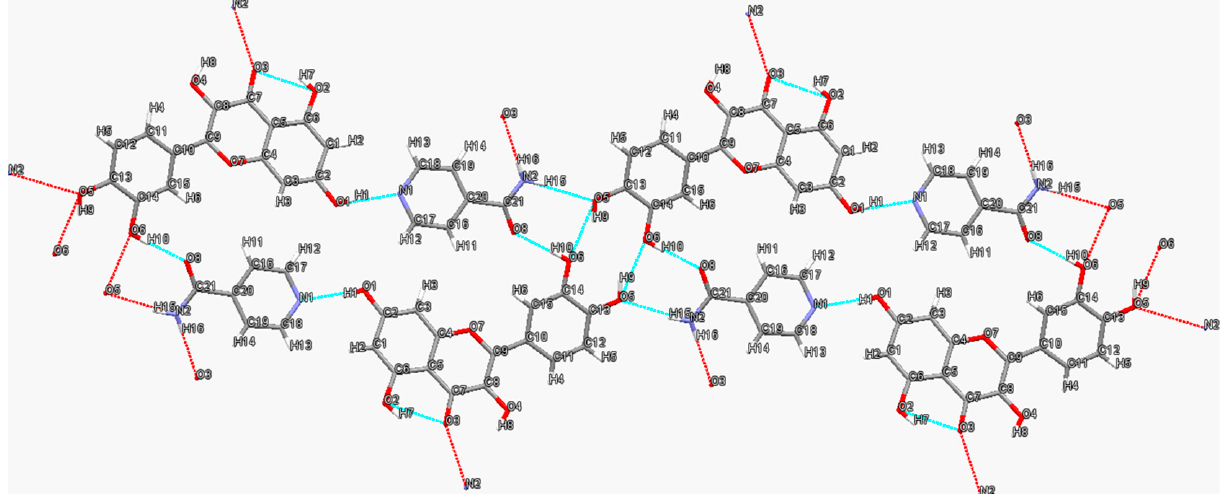
Figure 2. Two-dimensional hydrogen bonding network in quercetin–isonicotinamide cocrystal. Hydrogen bonds are indicated by blue dashed lines. Red dashed lines indicate further interactions with other molecules not shown.